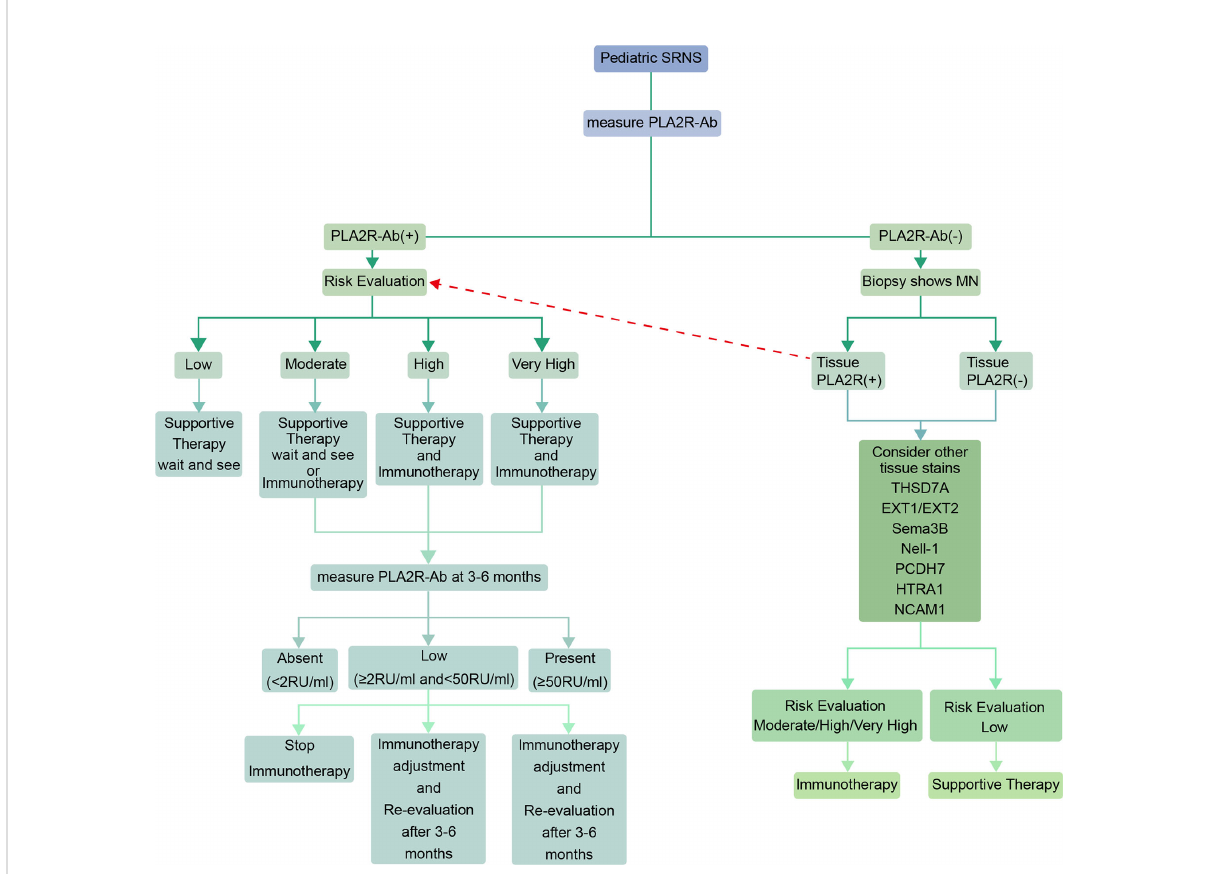
FIGURE 1 Algorithm for the diagnosis and treatment advice in pediatric MN patients (In cases of pediatric steroid-resistant nephrotic syndrome). The risk evaluation can be based on recommendations in the 2021 KDIGO guidelines for adult MN (56). The interval between PL2AR antibody levels measurement is generally 3-6 months, and it should be shortened for pediatric patients with high baseline levels. (Patients with initial positive PLA2R staining and positive antibodies in sera whose antibodies turn to negative spontaneously or following immunotherapy should be in the low risk category. Patients who have not undergone treatment or have relapsed after long-term complete remission may be in the moderate/ high/very high risk categories when the tests show positive for PLA2R staining but negative for antibodies in sera. PLA2R antibodies are sometimes undetected because the buffer capacity of the kidney is not exceeded)